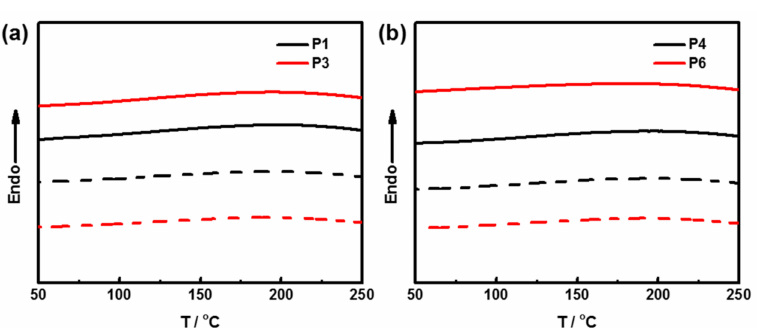
Figure 4. TGA traces of polymer.